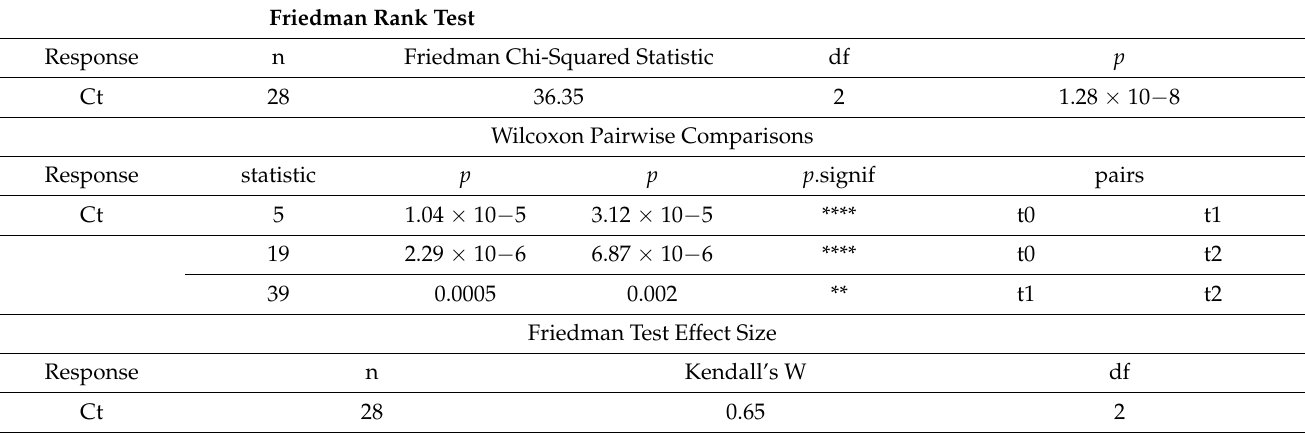
Table 2. The statistical results of the non-parametric tests (Friedman, Wilcoxon) for Lyme disease. The asterisks denote significance codes, namely ‘****’ stands for p -value < 0.0001 and ‘**’ stands for p -value < 0.01, after Bonferroni correction.